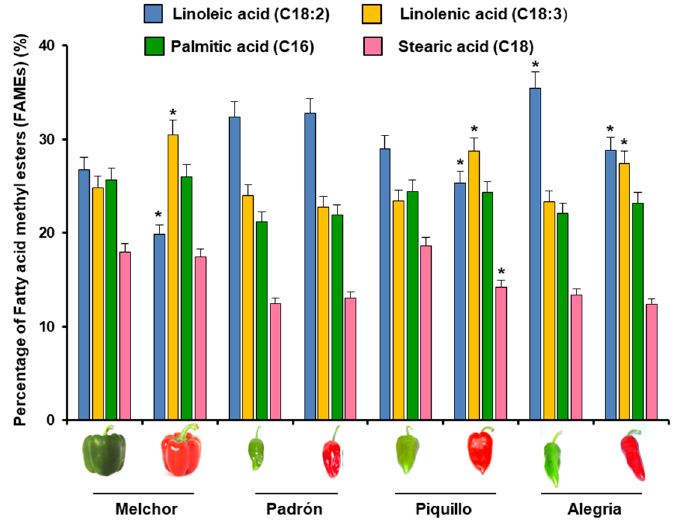
Figure 3. Fatty acid composition (GC/MS) of fruits from four pepper varieties with different capsaicin content expressed as percentage of fatty acid methyl esters (FAMEs) (%). Asterisks indicate that differences between values of each FA within each variety were statistically significant at p < 0.05, in comparison to the green stage.